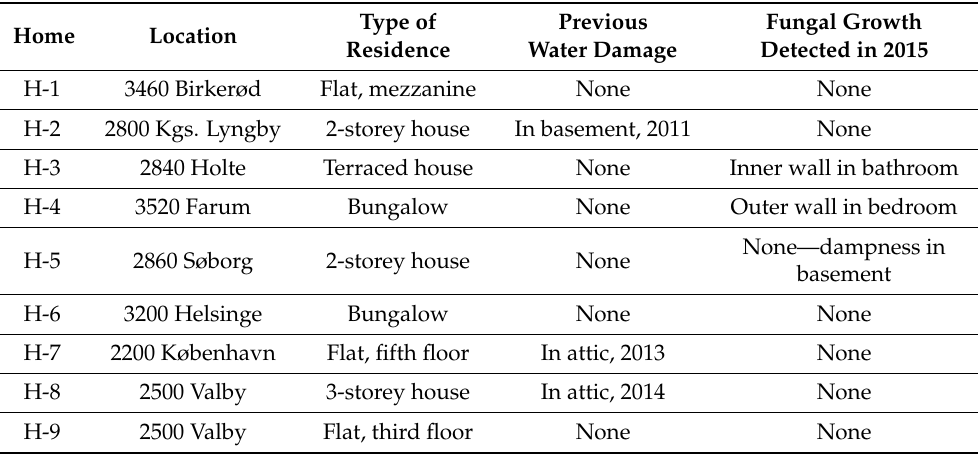
Table 1. Location (zip code and town) and description of the nine private Danish homes (H) sampled from January to March